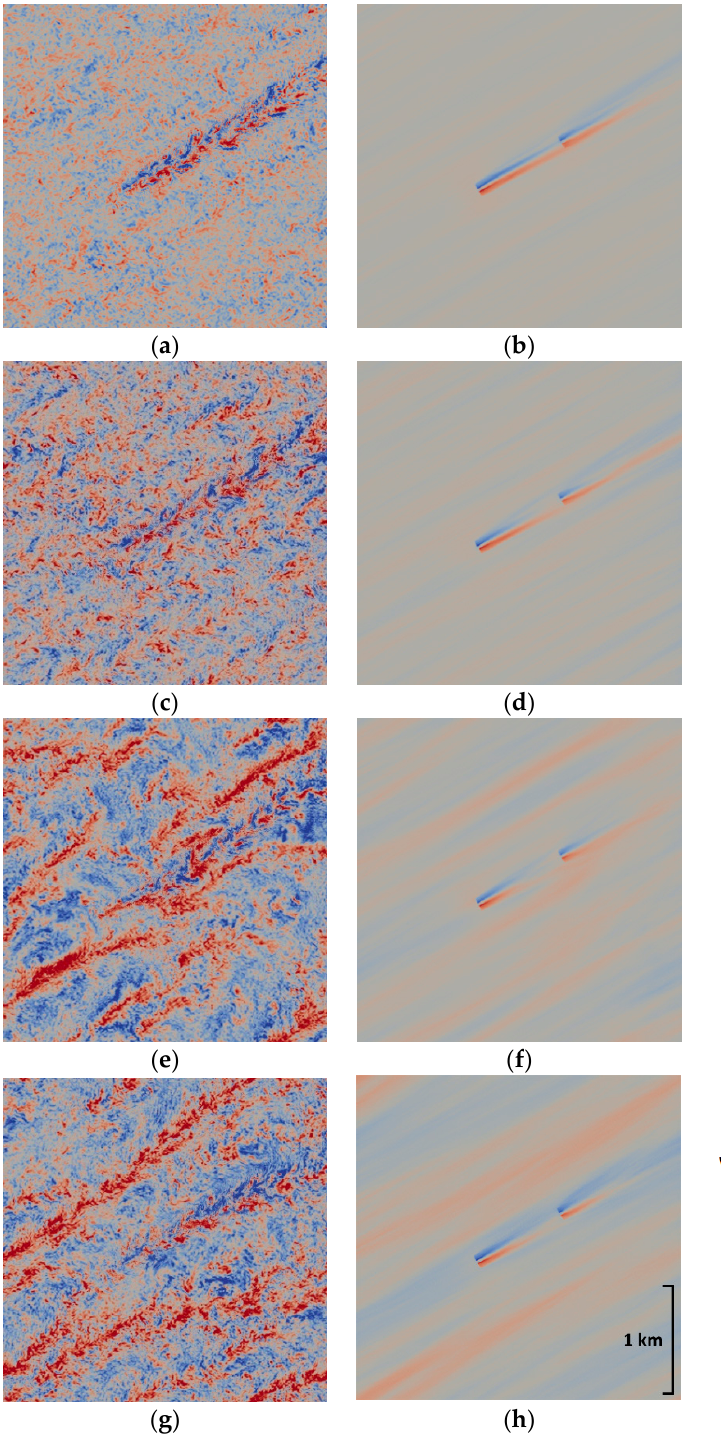
Figure 5. Top view of the instantaneous ( a , c , e , g ) and time-averaged ( b , d , f , h ) vertical velocities for NLABL, NHABL, ULABL, and UHABL (refer to Table 1) at hub-height (Z = 90 m).